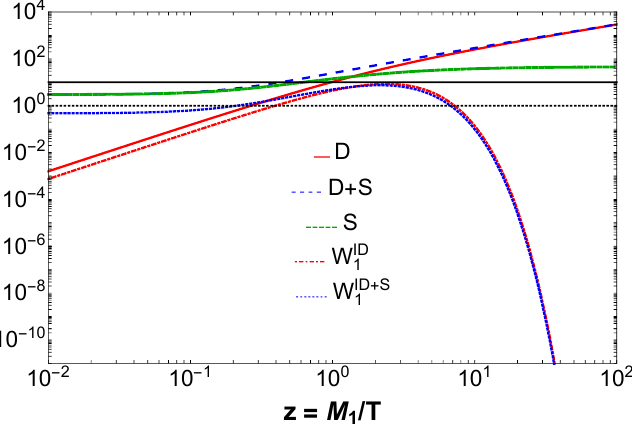
Figure 10 . Comparison among rates of various processes involved in the leptogenesis. The hori- zontal black line is the rate of the (cid:28) charged lepton (cid:13)avour interaction (cid:0) (cid:28) =Hz at the N 1 leptogenesis temperature T M 1 10 11 GeV. Domination of (cid:0) (cid:28) =Hz (over all the rates) has been (cid:24) (cid:24)